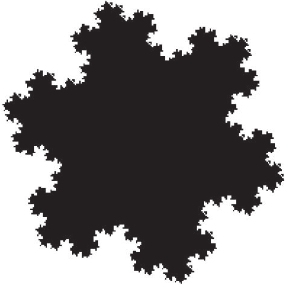
Figure 2.2. Model fractal binary